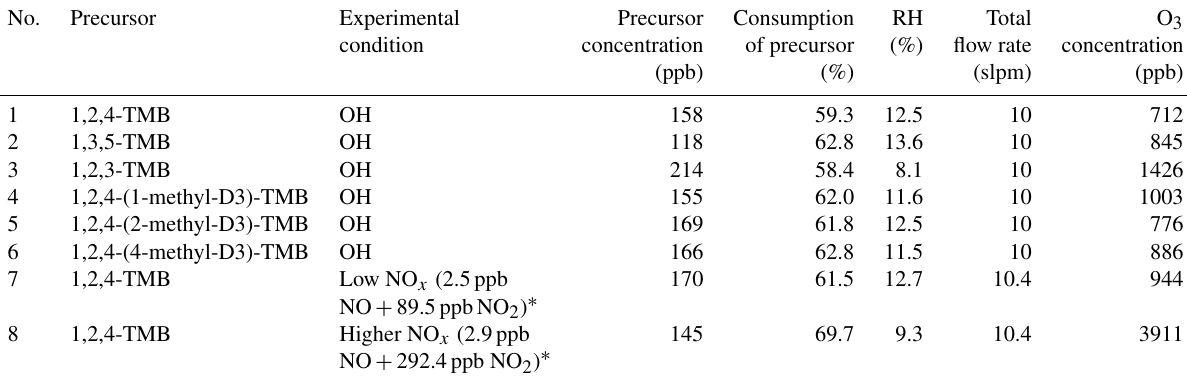
Table 1. Summary of experimental conditions. No.